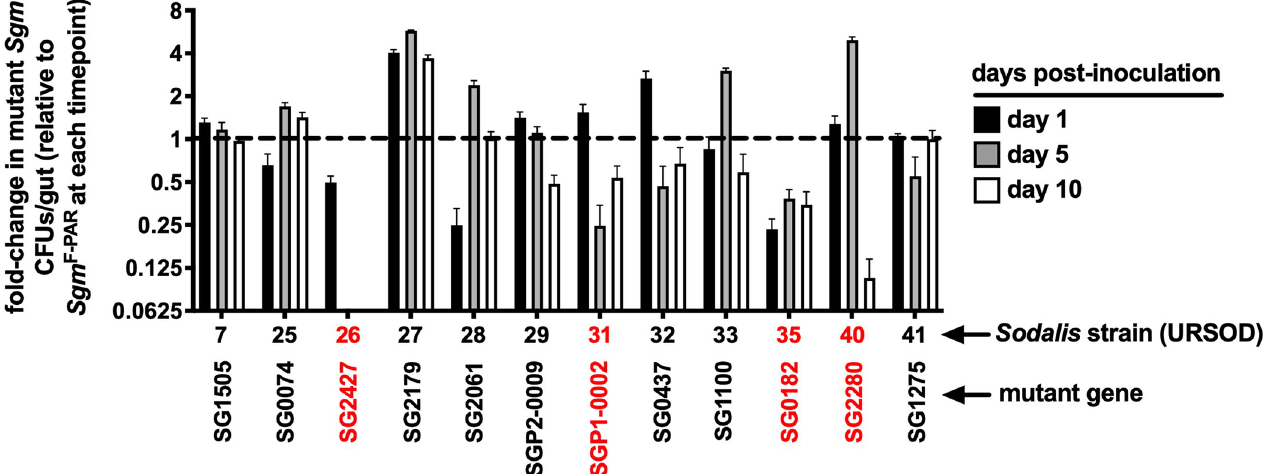
Fig 4. Colonization of tsetse with Sgm HIG mutants. Distinct groups of tsetse flies ( n = 25 per group) were inoculated per os (500 CFU/ml of blood) with one Sgm mutant strain or the parent strain ( Sgm F-PAR ). Midguts ( n = 5 per Sgm mutant and parent strain) were harvested at 1, 5, and 10 days post-inoculation and plated on selective media (kanamycin, 50 μ g/ml) to determine bacterial density (CFUs/gut). Bars represent the fold-change in the number of CFUs/gut of each Sgm mutant strain relative to the number of CFUs/gut of the Sgm parent strain Sgm F-PAR (mutant strain CFUs/parent strain CFUs) at each timepoint. The dashed line represents the value at which CFU/gut of parent strain Sgm F-PAR and each mutant strain are the same. Strains indicated in red represent those that presented colonization defects in tsetse’s gut. Mutant strains 26, 31, 35, and 40 grew to a significantly lower density, in tsetse’s midgut compared to the parent strain by day 10 ( p values for strains 26, 31, 35, and 40 = < 0.0001, 0.003, 0.001, and < 0.001, respectively). Statistical significance was determined via 2-way ANOVA with Tukey’s multiple comparisons (GraphPad Prism